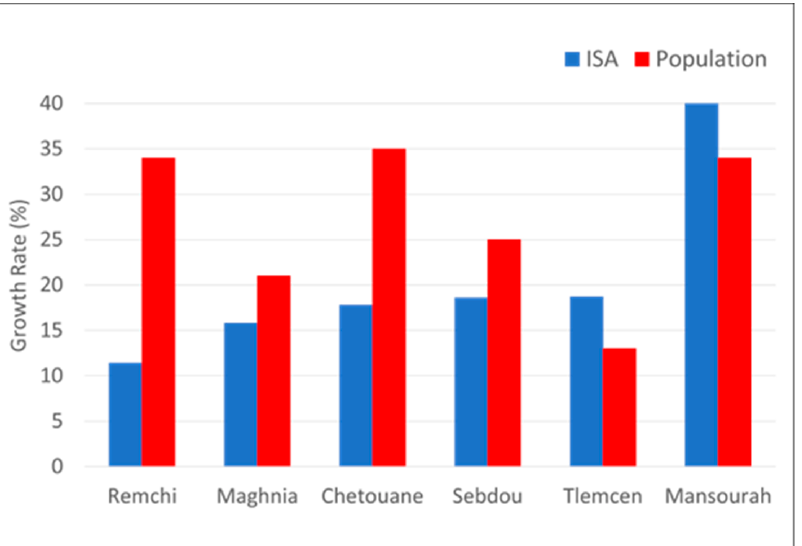
Figure 5. Change in ISA and population growth rates (%) between 2008 and 2018 for the communes with the largest populations in the Tlemcen wilaya.